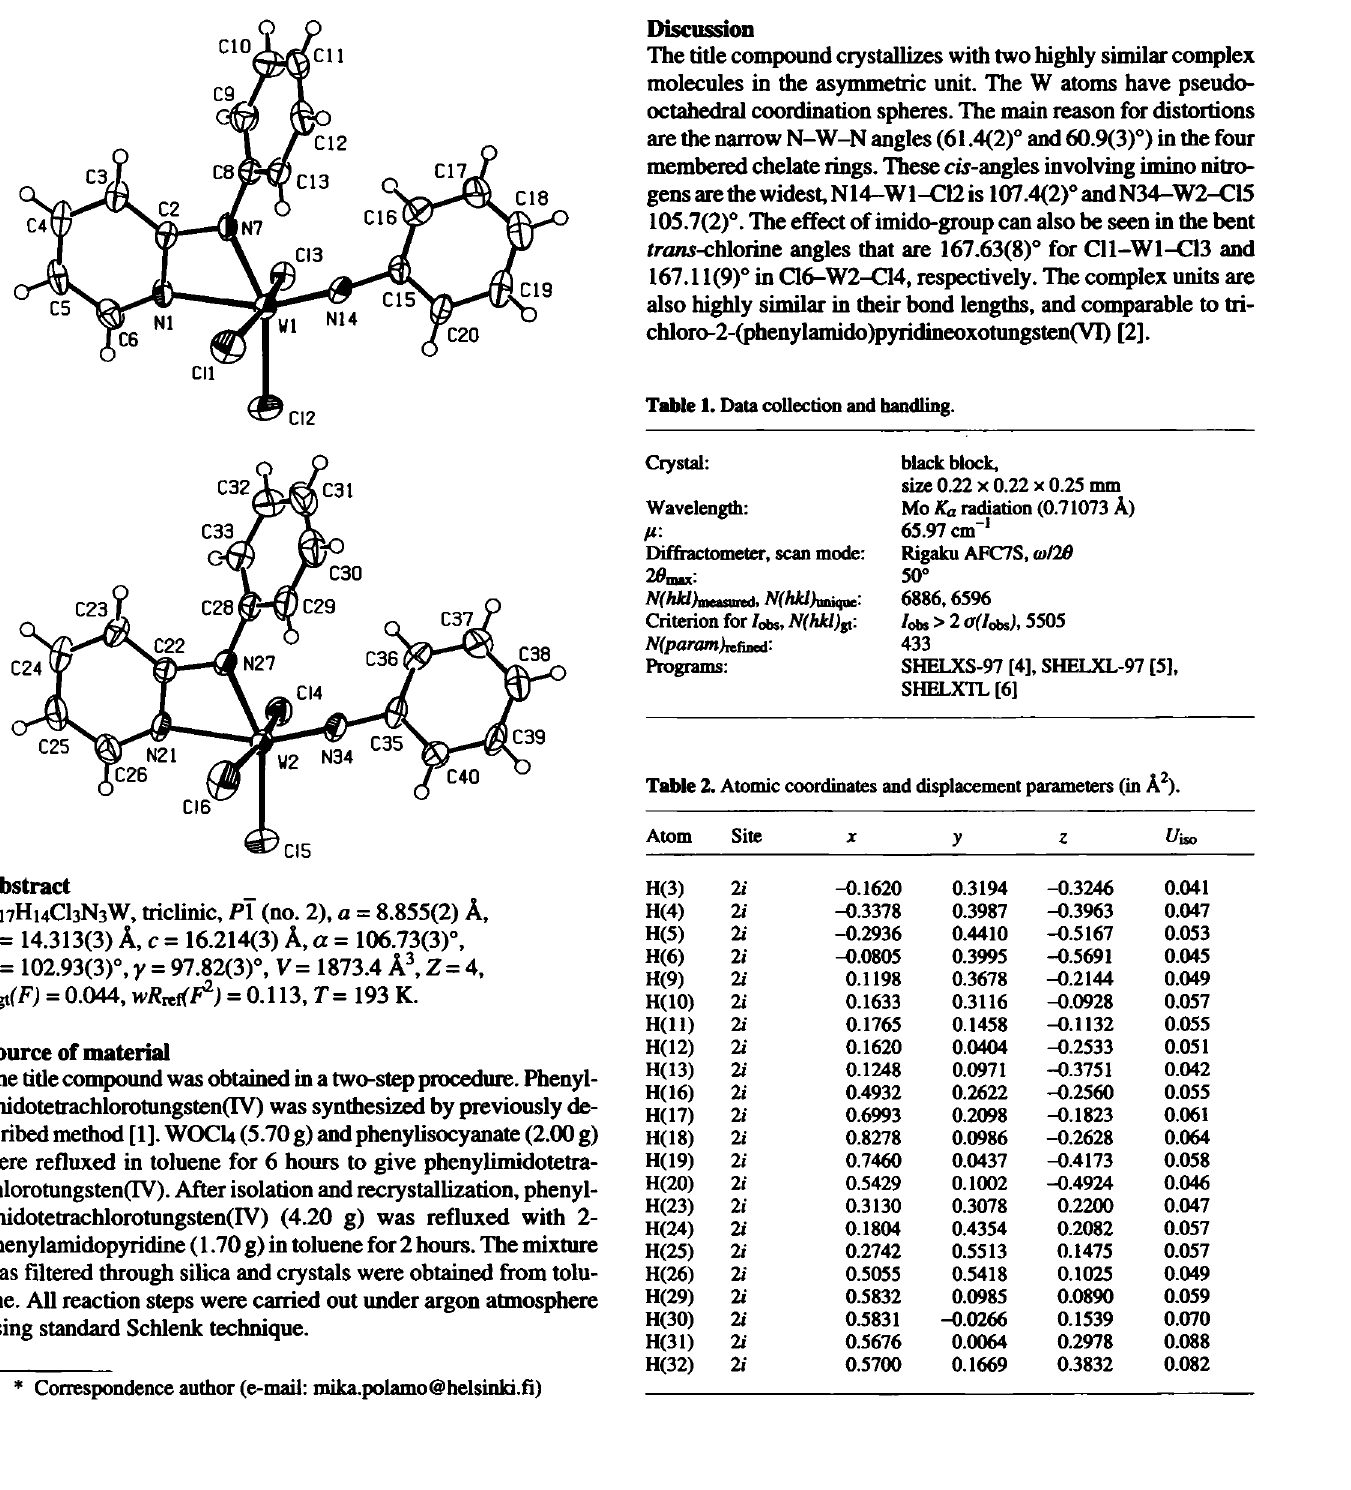
Table 1. Data collection and handling.